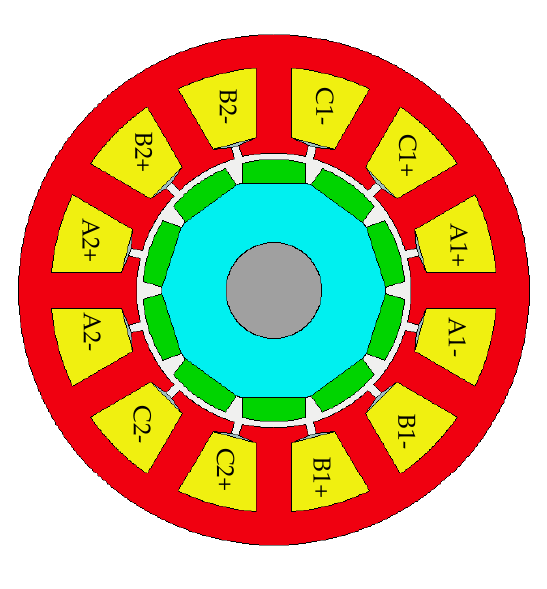
Figure 17. Cross-sectional view and winding pattern of the electric machine.